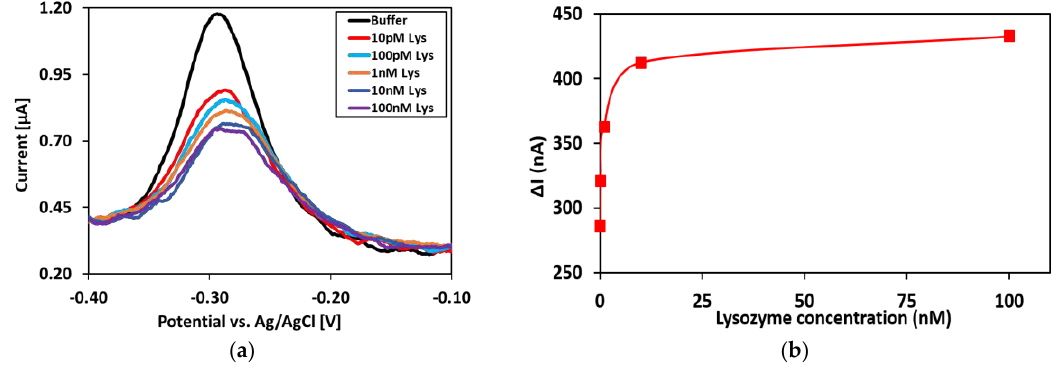
Figure A1. Square wave voltammograms obtained for different concentrations of lysozyme in 10 mM Figure A1. ( a ) Square wave voltammograms; and ( b ) the calibration curve obtained for different PBS buffer. concentrations of lysozyme in 10 mM PBS